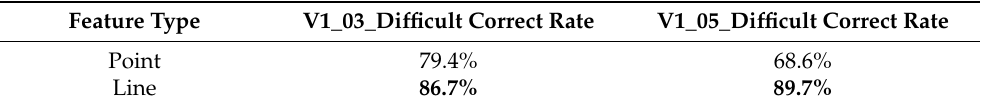
Table 1. Result of feature extraction and matching.